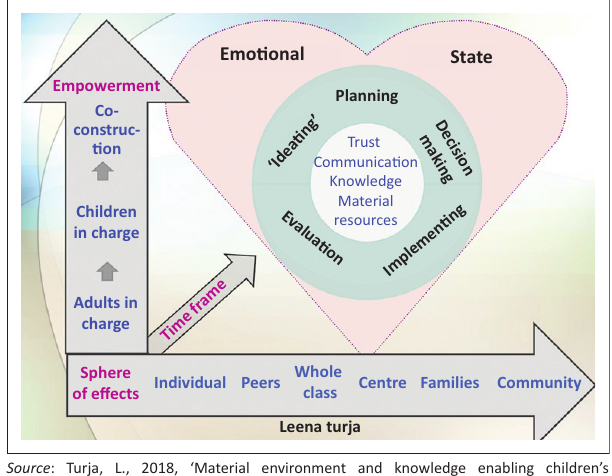
FIGURE 1: Model of children’s participation in the early childhood education